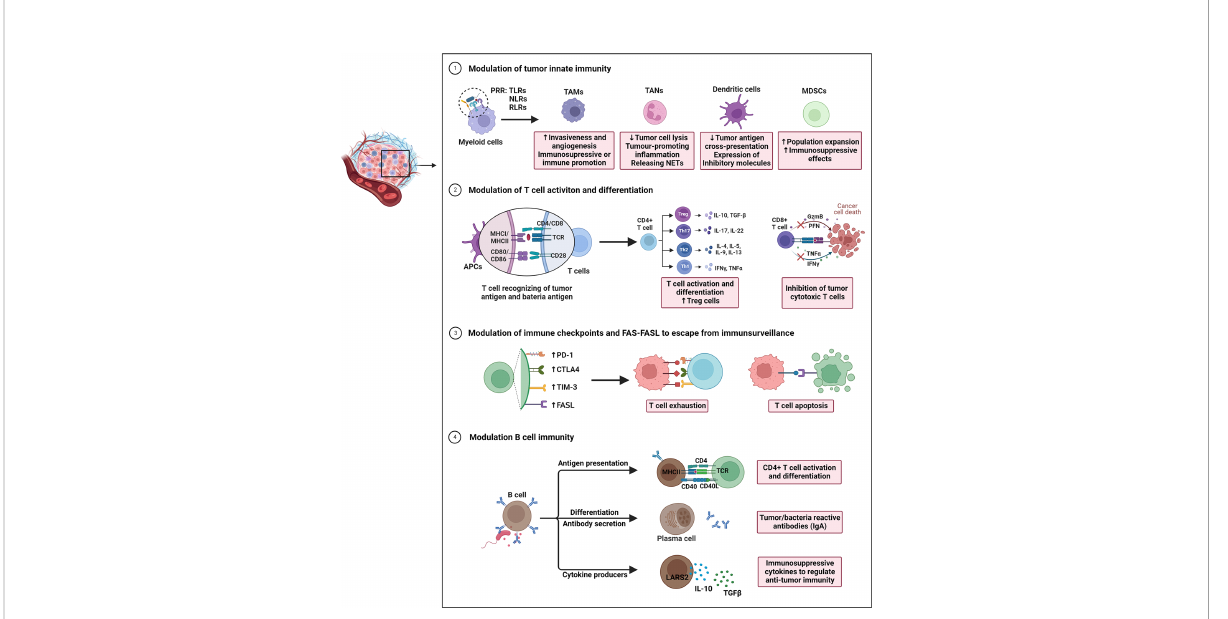
FIGURE 1 Overview of gut microbiota-modulated immune responses in tumor progression. The underlying actions and mechanisms by which the microbiota affects tumor immune escape are summarized as follows: 1) Under pathogenic conditions (dysbiosis), bacterial species that translocate through the epithelial barrier induce recruitment of myeloid cells. Myeloid cells recognize microbes via their pattern recognition receptors (PPR). During this process, the immunosuppressive mechanisms observed in the tumor microenvironment (TME) are activated underlie chronic infections. 2) Intestinal microbiota and intra-tumoral bacteria can be directly presented by antigen-presenting cells, thereby driving T cell activation and differentiation of CD4+T cell subsets into Th1, Th2, and Th17 or Tregs. Microbiota may also inhibit the dendritic cells ’ antigen presentation, consequently decreasing the CD8+T cell response. 3) By modulating T cell immune checkpoint receptor-ligand pairs (e.g., CTLA-4/CD80/CD86 and PD1/PD-L1/PD-L2), they impact T cell exhaustion, and directly impacting ef fi cacy of immune checkpoint inhibitors. Additional mechanisms of immune escape include expression of the apoptotic proteins FAS/FASL to induce immune cell apoptosis. 4) Gut microbiota may also regulate B cell in fi ltration, development, and polarization. These B cells exert anti/pro-tumor immunity through acting as APCs to reshape T cell responses, secreting tumor/bacteria-speci fi c antibodies (IgA), and producing cytokines (IL-10, TGF b ), all of which are associated with immune processes in